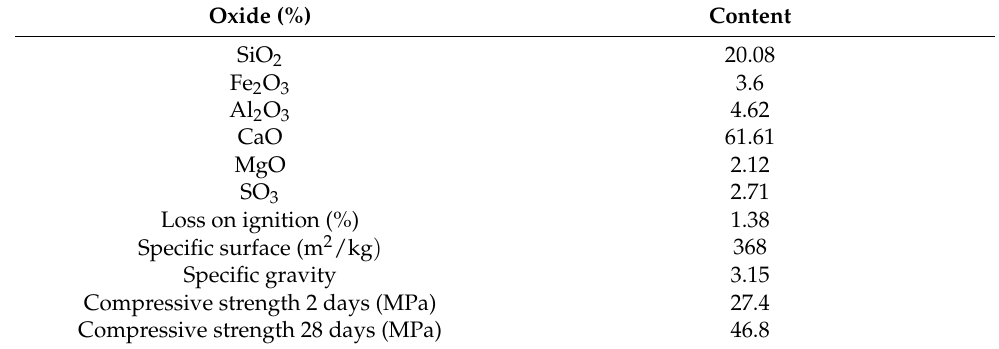
Table 1. Physical properties of